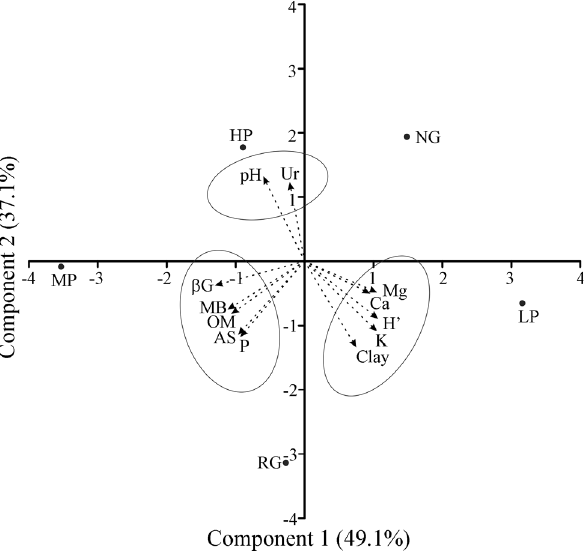
Figure2 - Principalcomponentanalysisofthechemical,biochemicaland microbiological characteristics of soil under different grazing intensities. AS - arylsulfatase, (cid:2) G - (cid:2) -glucosidase, HP - high grazing pressure, LP - low grazing pressure, MB - microbial biomass, MP - moderate grazing pressure, NG - never-grazed native vegetation, RG - regenerated vegeta- tion, Ur - urease.